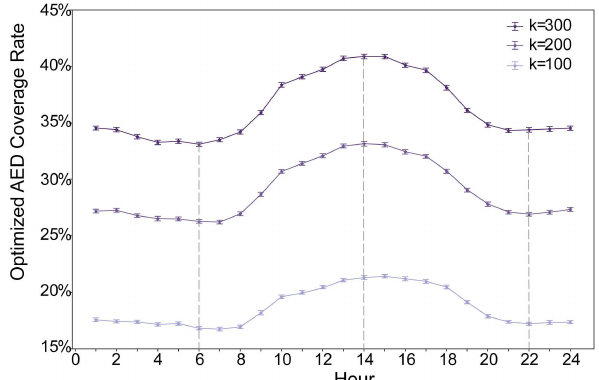
) refers to the h I h